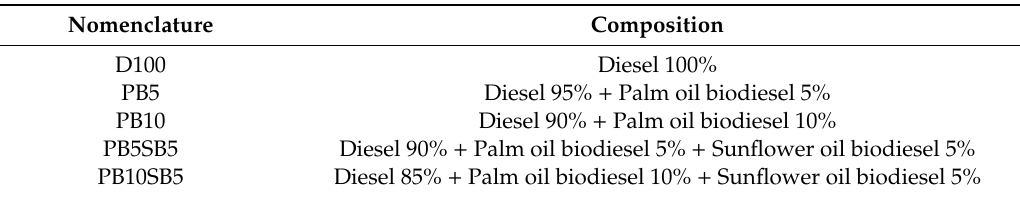
Table 3. Nomenclature and composition of fuels.